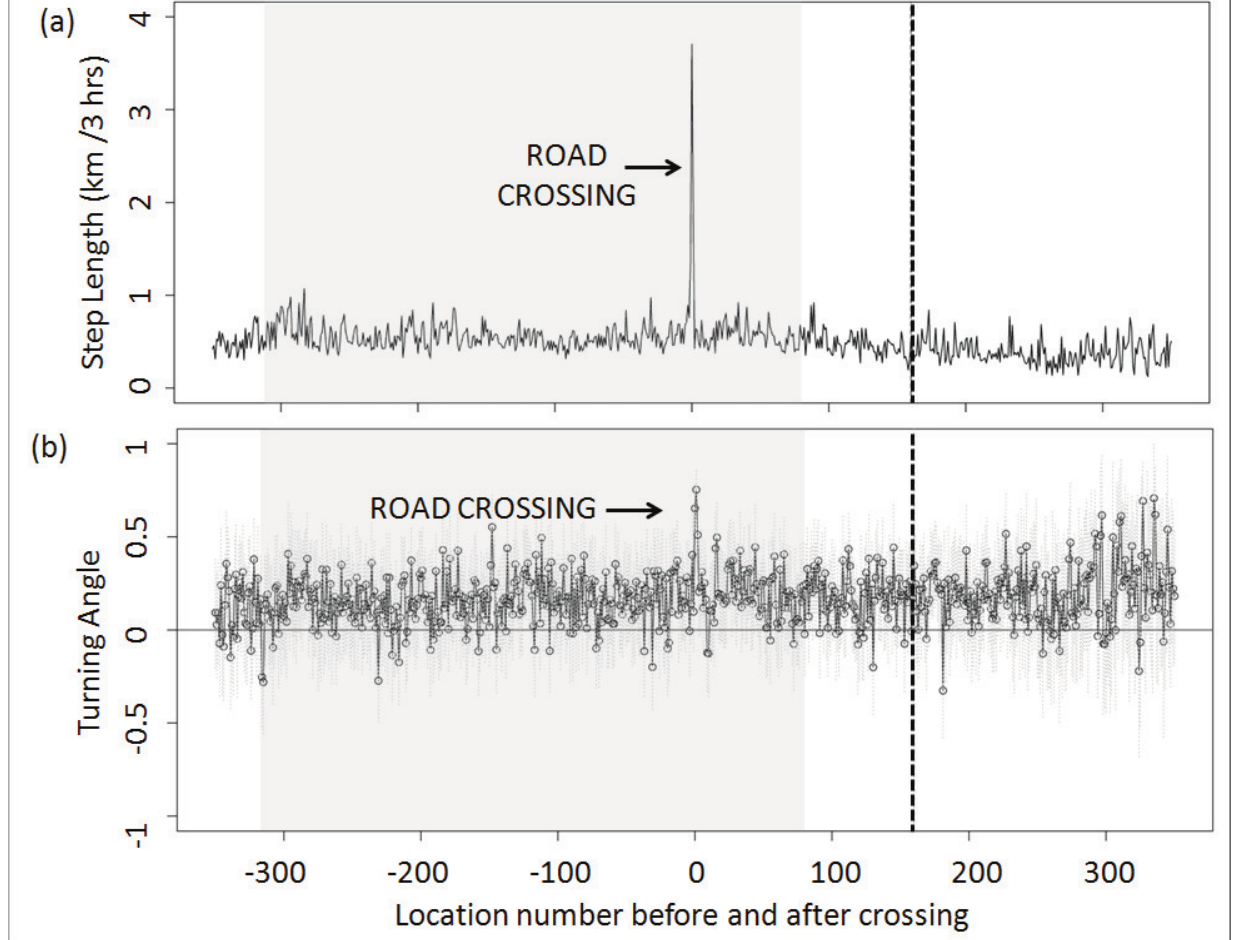
Fig. 4. Step length (upper graph) and turning angles (lower) of reindeer during 45 days (350 radio-locations) before (cid:68)(cid:81)(cid:71)(cid:3)(cid:68)(cid:73)(cid:87)(cid:72)(cid:85)(cid:3)(cid:87)(cid:75)(cid:72)(cid:3)(cid:70)(cid:85)(cid:82)(cid:86)(cid:86)(cid:76)(cid:81)(cid:74)(cid:3)(cid:82)(cid:73)(cid:3)(cid:85)(cid:82)(cid:68)(cid:71)(cid:3)(cid:53)(cid:89)(cid:3)(cid:23)(cid:24)(cid:17)(cid:3)(cid:55)(cid:75)(cid:72)(cid:3)(cid:70)(cid:85)(cid:82)(cid:86)(cid:86)(cid:76)(cid:81)(cid:74)(cid:3)(cid:82)(cid:70)(cid:70)(cid:88)(cid:85)(cid:86)(cid:3)(cid:68)(cid:87)(cid:3)(cid:87)(cid:75)(cid:72)(cid:3)(cid:79)(cid:82)(cid:70)(cid:68)(cid:87)(cid:76)(cid:82)(cid:81)(cid:3)(cid:70)(cid:82)(cid:71)(cid:72)(cid:71)(cid:3)(cid:19)(cid:15)(cid:3)(cid:76)(cid:81)(cid:3)(cid:87)(cid:75)(cid:72)(cid:3)(cid:70)(cid:72)(cid:81)(cid:87)(cid:85)(cid:72)(cid:3)(cid:82)(cid:73)(cid:3)(cid:87)(cid:75)(cid:72)(cid:3)(cid:191)(cid:74)(cid:88)(cid:85)(cid:72)(cid:17)(cid:3)(cid:55)(cid:75)(cid:72)(cid:3) shaded area indicates the estimated migration period; the dashed line indicates the average estimated calving